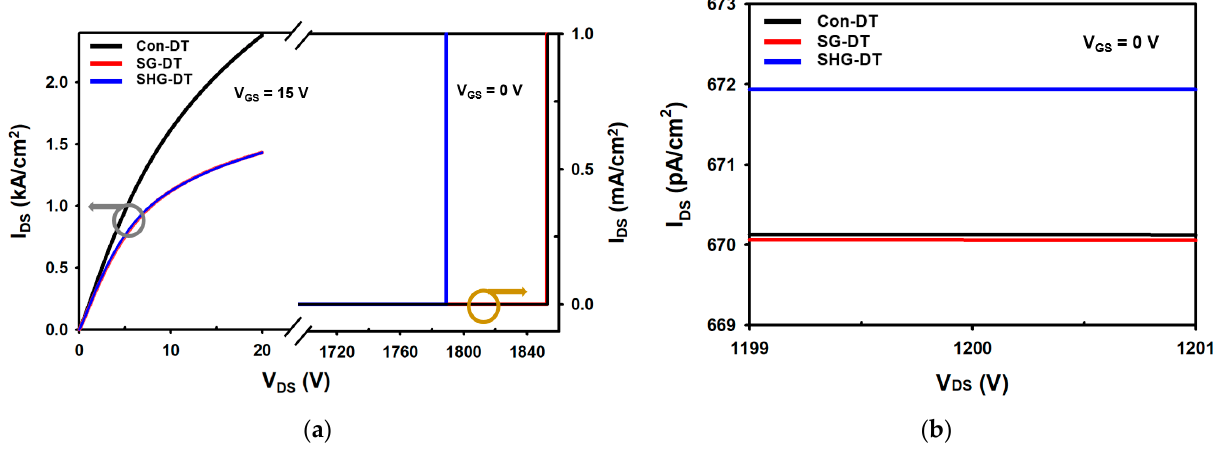
Figure 2. Comparison of Con-DTMOS, SG-DTMOS, and SHG-DTMOS. ( a ) Specific on-resistance and breakdown voltage. ( b ) Reverse leakage current.